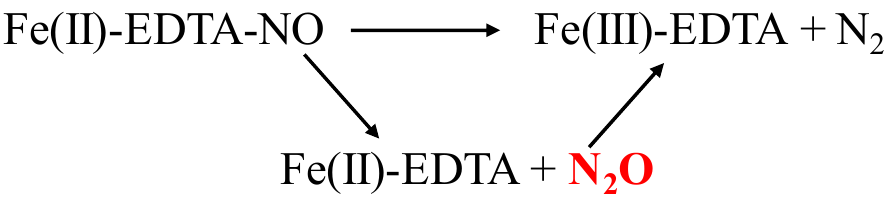
Figure 6. Reduction of NO via formation of N 2 O as an intermediate.